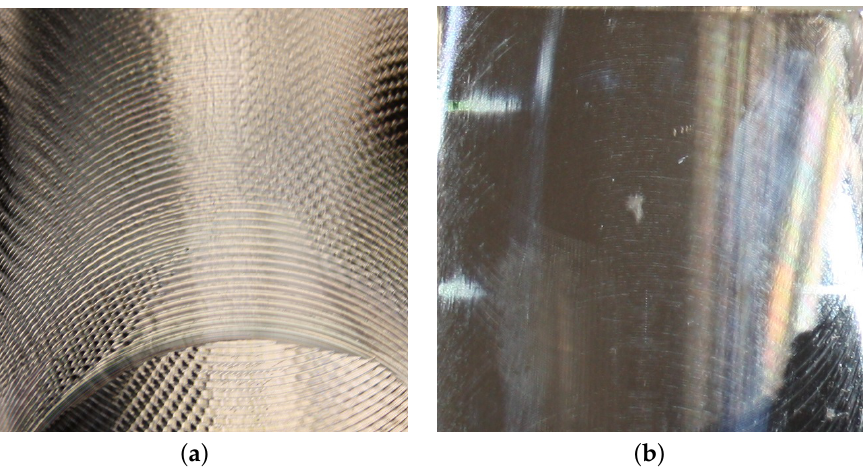
Figure 2. Workpiece surface finishing: ( a ) chatter; ( b ) no